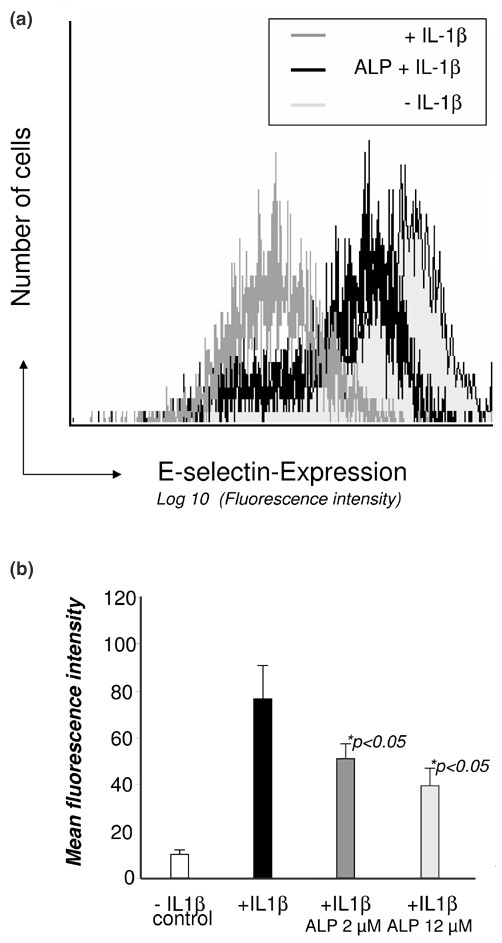
Inhibition of IL-1β-induced upregulation of E-selectin in glEND.2 cells by ALP. (a) Inhibition of IL-1β-induced upregulation of E-selectin in glEND.2 cells by antileukoproteinase (ALP). Determination of E-selectin expression on glEND.2 cells was performed by FACS analysis after staining with a biotinylated anti-E-selectin mAb and phycoerythrin-labelled-streptavidin. The histograms obtained after gating on glEND.2 cells for forward and sideways light-scattering properties and counting of 5,000 events demonstrate the increasing surface expression of E-selectin in response to stimulation with IL-1β (curve shifted furthest to the right) compared with the unstimulated control (leftmost curve). The intermediate curve represents the E-selectin distribution on glEND.2 cells pretreated with ALP (2 μM) before stimulation with IL-1β. (b) Inhibition of E-selectin expression by ALP. Mean fluorescence intensities were determined as a measure of the E-selectin expression levels in six independent experiments and used to calculate the mean and SEM for the following experimental conditions of glEND.2 cell activation: no stimulus (- IL-1β control), IL-1β stimulus (+IL-1β), IL-1β stimulation after pretreatment with ALP for 2 hours (+IL-1β ALP 2 μM and +IL-1β ALP 12 μM). The inhibitory effect of pretreatment with ALP on E-selectin expression was statistically significant for both concentrations of ALP (*p < 0.05).